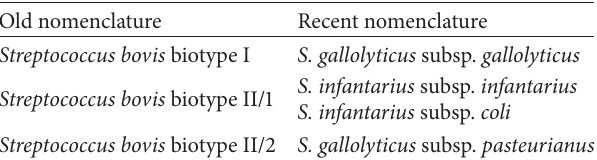
Table 1: Nomenclature of the principal human species of Streptococ- cus bovis